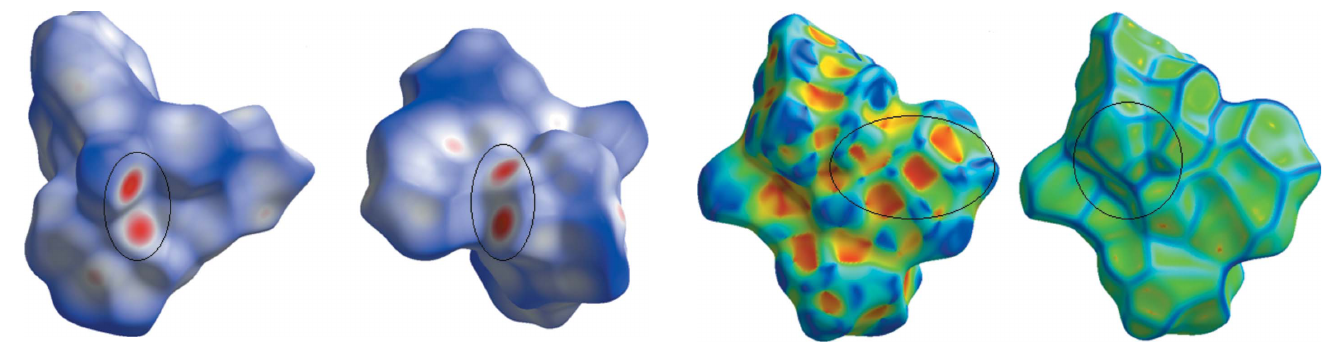
Figure 3 Hirshfeld surface mapped over d norm generated for the title compound.